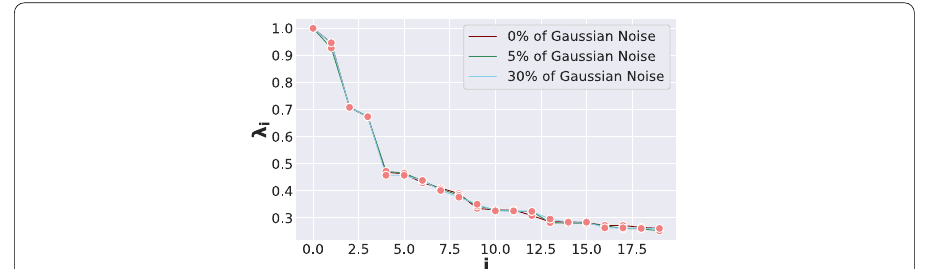
Fig. 8 The eigenvalues of the Koopman operator approximated by graphKKE for different percentages of Gaussian noise added to the MovingPic